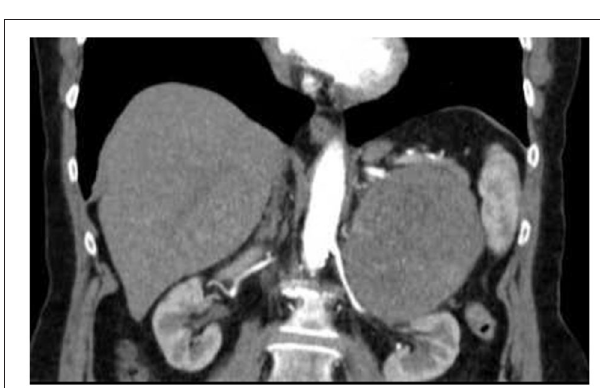
FIGURE 2 | CT-scan of the abdomen. Coronal-view CT scan of the abdomen reveals a large abdominal mass measuring 10 × 8 × 10cm without